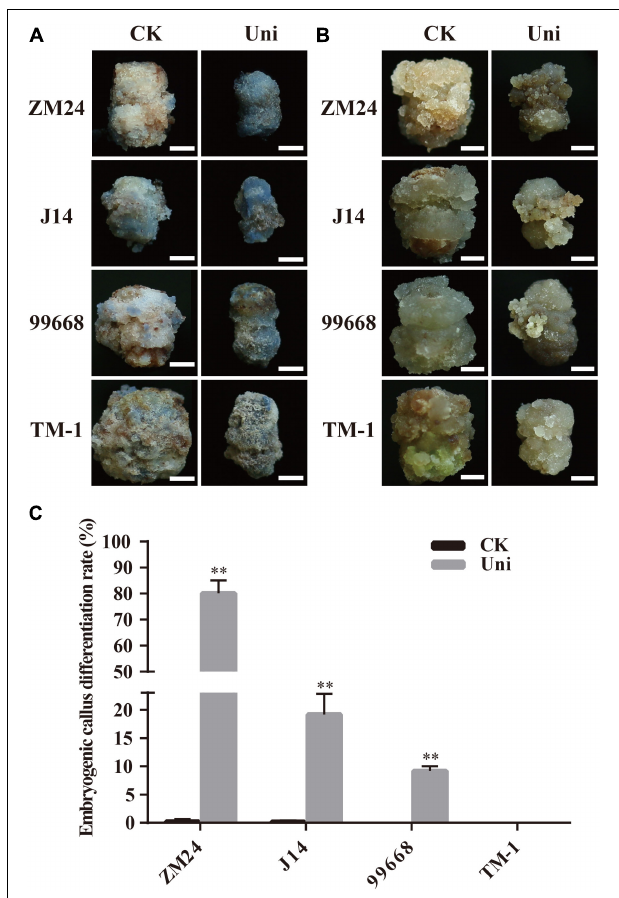
FIGURE 2 | Uniconazole positively promotes the conversion of callus into an embryogenic callus (EC) during cotton tissue culture. (A) Alkaline phosphatase staining of callus in ZM24, J14, 99,668, and TM-1 at 30 days (d) in culture. Scale bar = 5 mm. (B) Callus appearance of ZM24, J14, 99,668, and TM-1 at 40-day induction under CK or uniconazole (Uni) treatment. Scale bar = 5 mm. (C) EC differentiation rate of ZM24, J14, 99,668, and TM-1 at 80-day induction under CK or Uni treatment. The double asterisk indicates statistical significance at p <